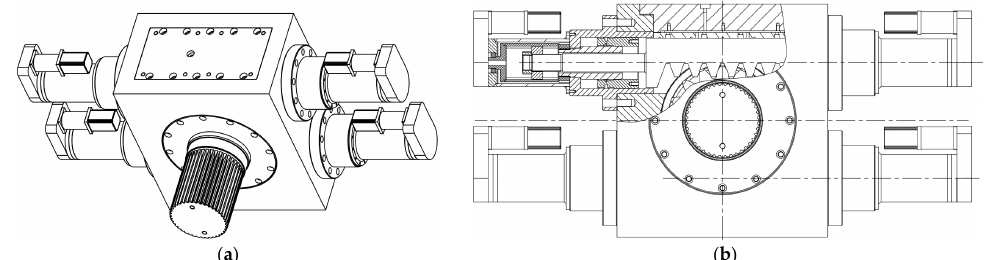
Figure 9. Structure of the gear-rack swing hydraulic cylinder: ( a ) three-dimensional view and ( b ) profile.